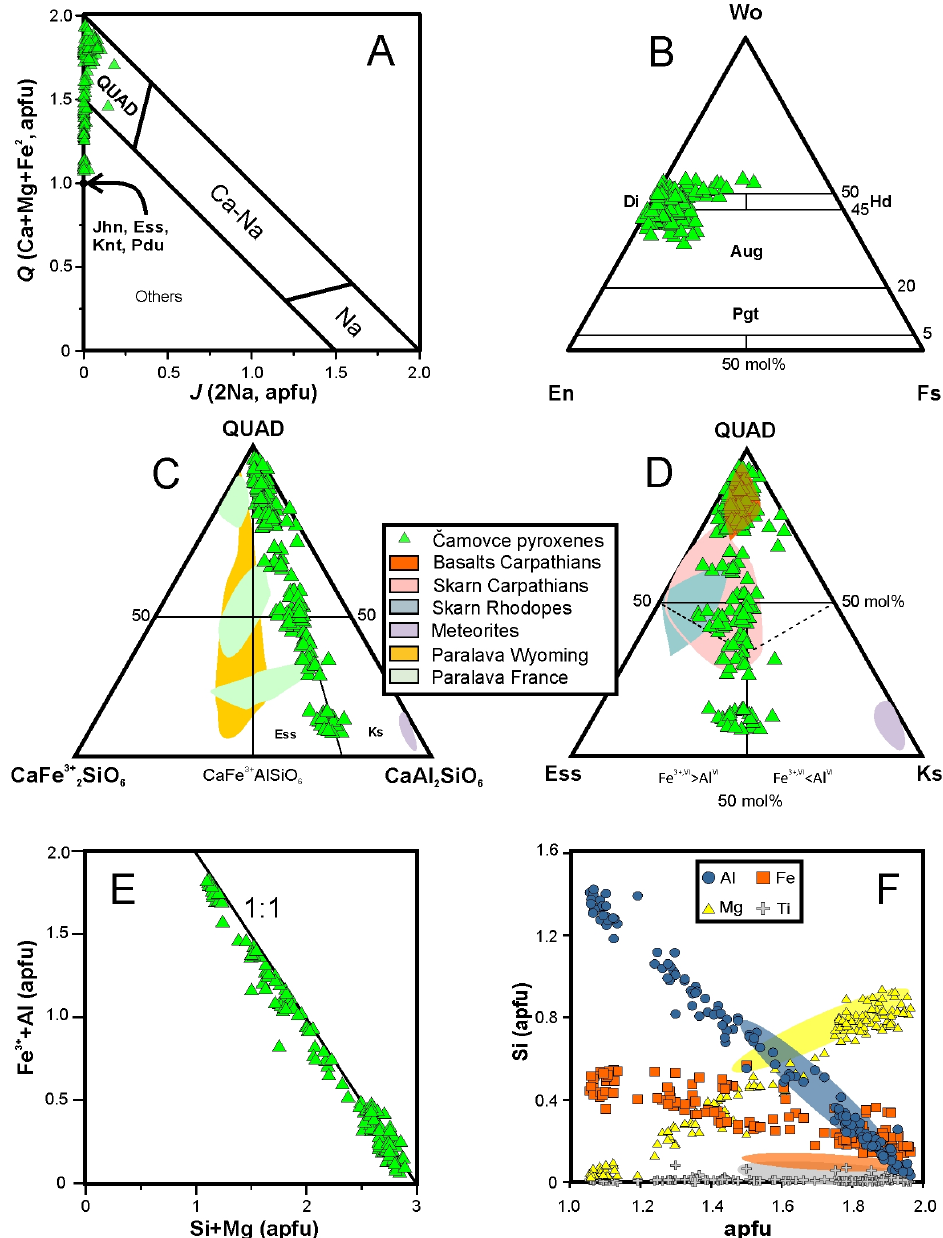
Figure 7. Classification diagrams and compositional trends of pyroxenes: ( A ) J – Q classification diagram for pyroxenes [32] with projection of pyroxenes from ˇCamovce; ( B ) Classification diagram of QUAD pyroxenes; ( C , D ) Classification diagrams for pyroxenes from the ˇCamovce with fields for pyroxenes from carbonaceous chondrites [10–12], paralavas of the Lapanouse ‐ de ‐ Sévérac region, France [3] and WY, USA [2]; skarns of the Romanian Carpathians [7] and Rhodopes, Bulgaria [33]. The orange, semitransparent area in D denotes the field of magmatic Al ‐ rich clinopyroxenes from south Slovakian basalts formed by the interaction with carbonate ‐ syenite xenoliths (unpublished); ( E ) Coupled substitution Fe 3+ + Al = Si+Mg in pyroxenes from Č amovce; ( F ) Relations among Al, Fe (total), Mg, Ti and Si for pyroxenes from Č amovce. Colored ellipses express the compositional range of pyroxenes from skarns in Romanian Carpathians [7]. Wo contents in B–D have been calculated from the residual Ca (apfu) after creating Ca ‐ Tschermak components (CaTiAl 2 O 6 , CaFe 3+2 SiO 6 and